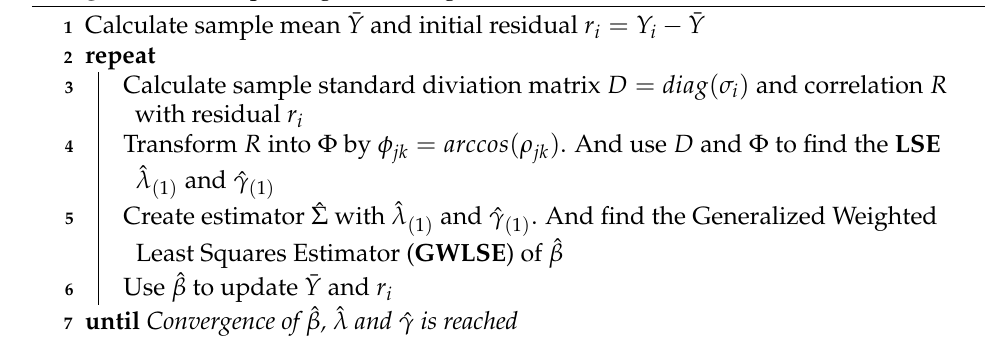
Algorithm 2: Simple Regression